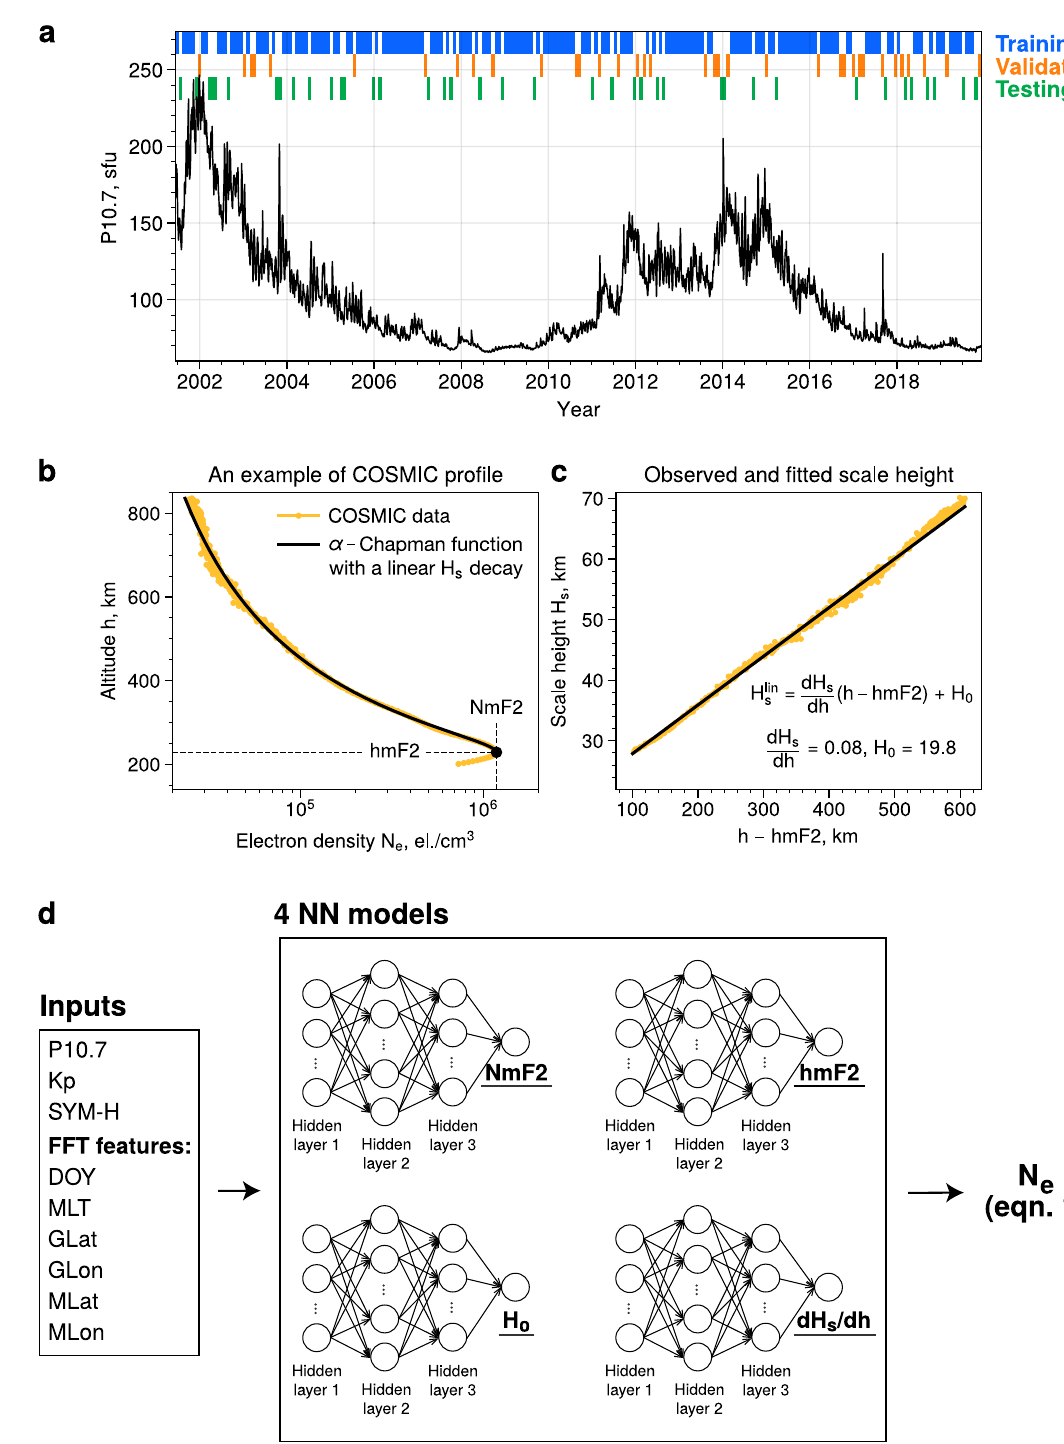
Figure 1. ( a ) Distribution of the P10.7 index and the data splitting; ( b ) An example of the COSMIC profile (orange) and the fitted data using the alpha-Chapman function with a linear decay of scale height with altitude (black); ( c ) Observed scale height and the linear fit; ( d ) Schematics of the model shows little diurnal variation and likely comes from the fact that during solstices, polar regions in the local- summer hemispheres are sunlit at all MLTs due to absence of dark nights 21 . One also observes several regions of enhanced scale height gradient (Fig. 2(j,k)), namely two mid-latitude stripes ( ∼ 40 ◦ MLat in both hemispheres) which remain at all local times, and a sunrise peak ( ∼ 05–07 MLT) around the magnetic equator. The sunrise peak is likely connected with the so-called morning overshoot of electron temperature. It happens due to energy exchange between the newly ionized photoelectrons and ambient electrons, which is more efficient in regions